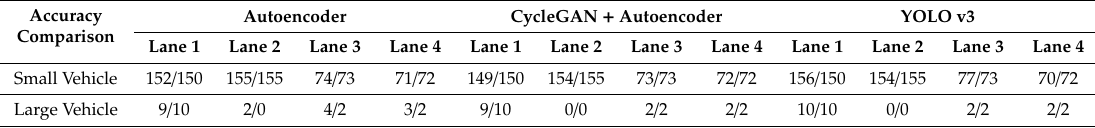
Table 6. The accuracy comparison for classifying vehicle